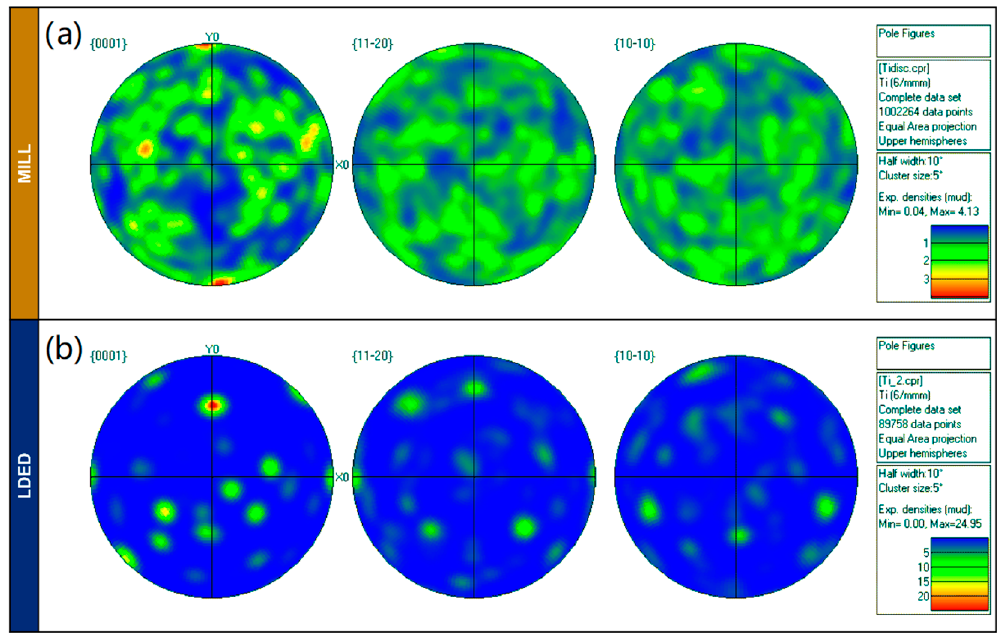
Figure 7. ( a ): EBSD pole figures for MILL. ( b ): EBDS pole figures for LDED materials. Density of both materials was similar. The MILL cp-Ti had a density of 4.5141 ± 0.0002 g/cm 3 , whereas the cp-Ti obtained as result of the LDED process had a density of 4.5170 ± 0.0003 g/cm 3